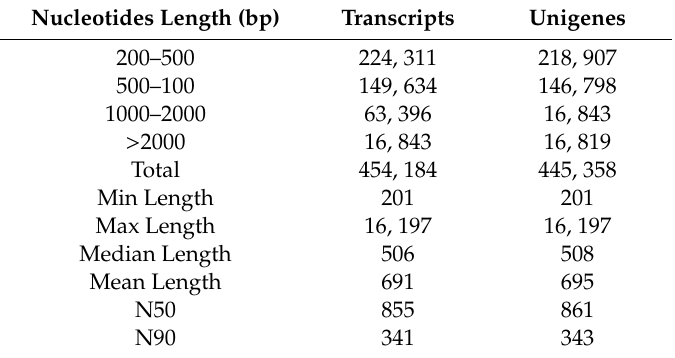
Table 3. Summary statistics of the annual ryegrass transcriptome